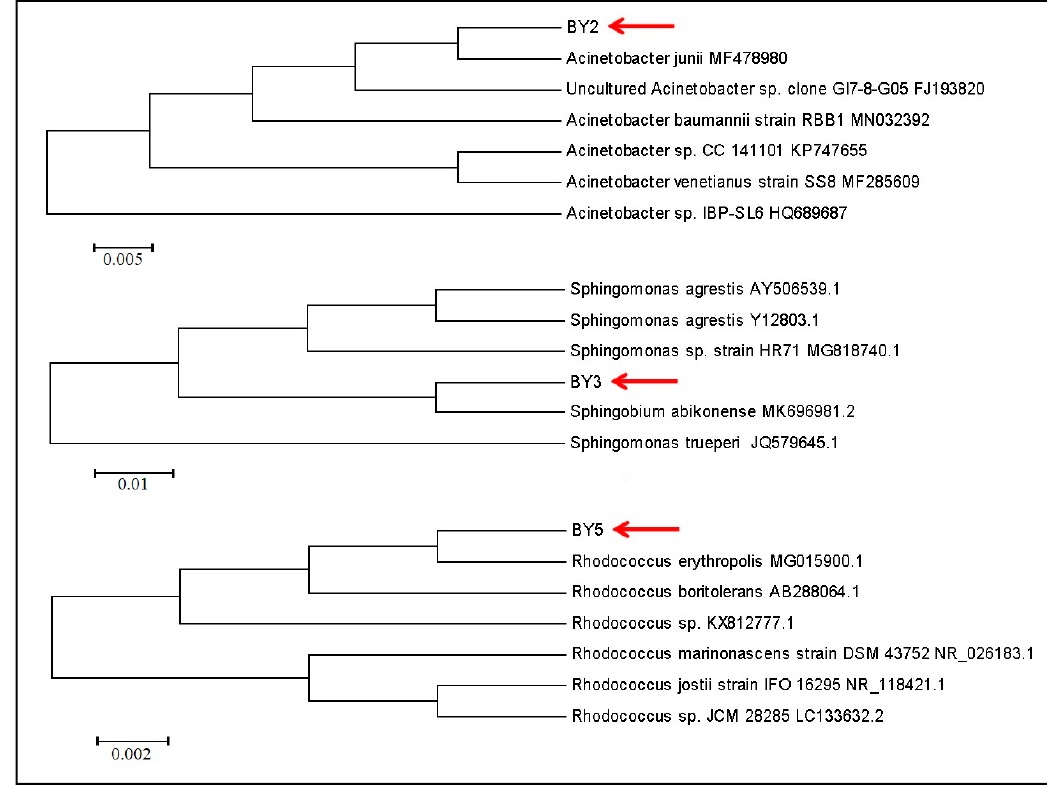
Figure 3. Phylogenic tree of the 16S rDNA gene sequence of BY2, BY3, and BY5 . Table 3. Species and Gram–Färbung tests for the isolated strains.